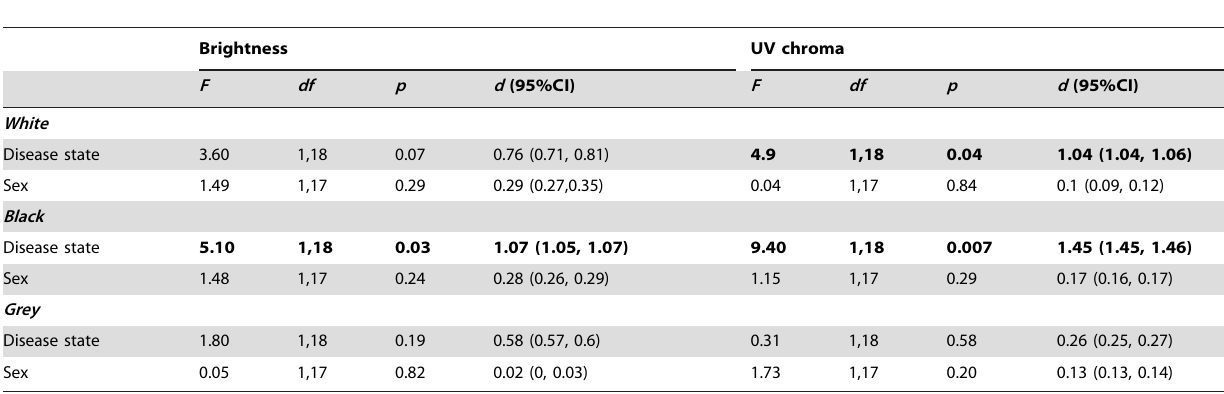
Table 1. GLM showing effects of disease state (affected versus unaffected by avian keratin disorder) and sex on color variables of white, black, and grey feathers of black-capped chickadees before wash treatment.